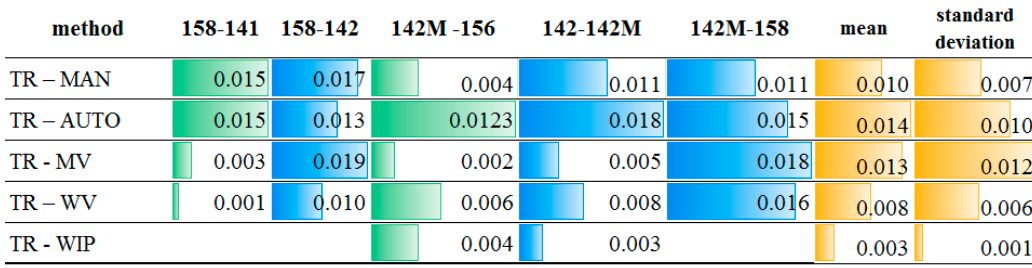
( b ) Figure 11. The centres identified with different solutions: MV —mass centre of all target points, WV —target centre determined by the variant II approach, WIP —variant III, MAN —manual identification of the target centre, and AUTO —automatic. ( a ) Target 97 (regular, good quality), ( b ) target 106 (incomplete, irregular). According to the conditions (COND.1-5), it can be seen that, for target 97, COND.1 indicates that variant I of the target centre solution should be used. Similarly, for target 106, COND.5 indicates that variant III of the target centre solution should be used. The numerical results are presented in